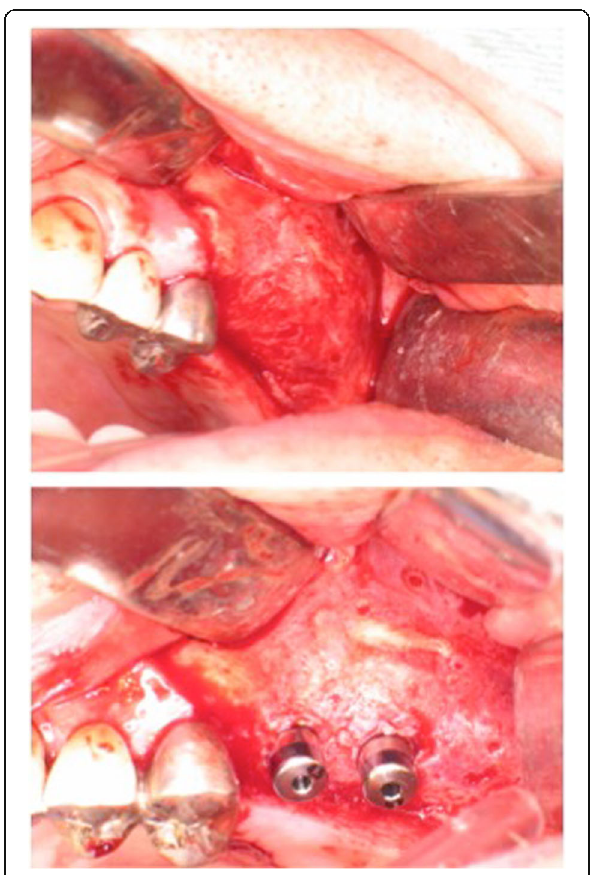
Fig. 5 Plate removal and insertion of two implants 6 months after